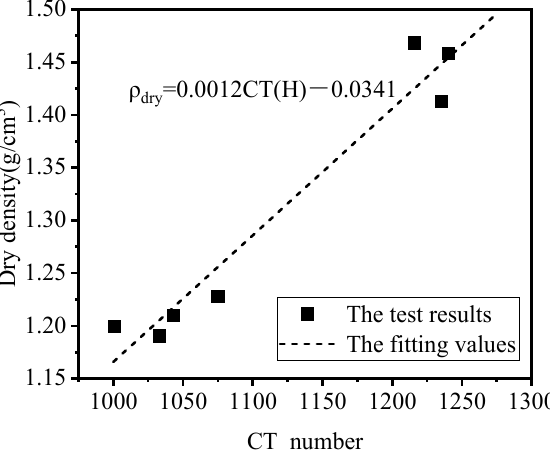
Figure 15. The relationship between CT number and dry density.